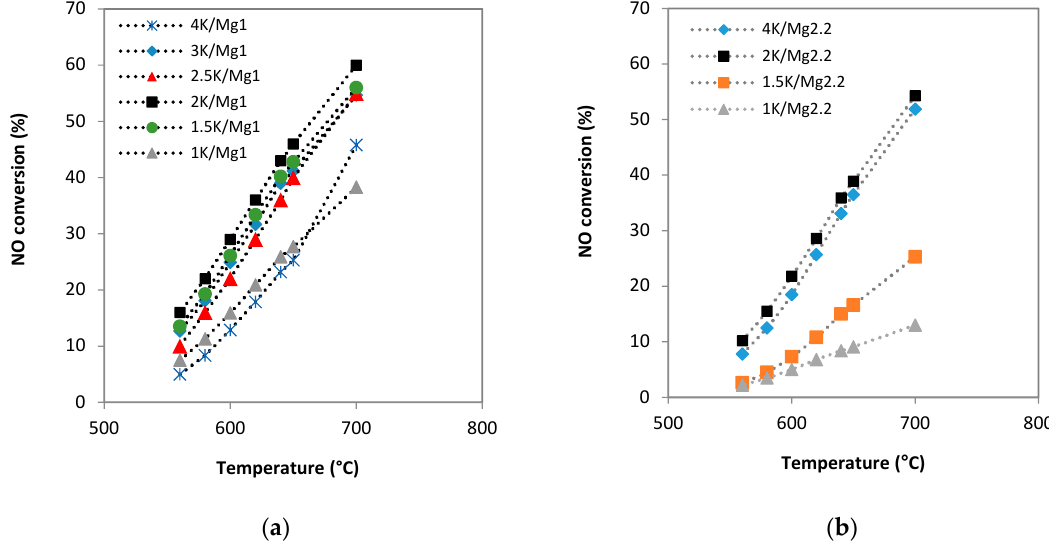
Figure 11. Temperature dependence of NO decomposition over: ( a ) the a K / Mg1 group of catalyst and ( b ) the a K / Mg2.2 group of catalysts. Conditions: 1000 ppm NO balanced by N 2 and GHSV = 6 L g − 1 h − 1 .